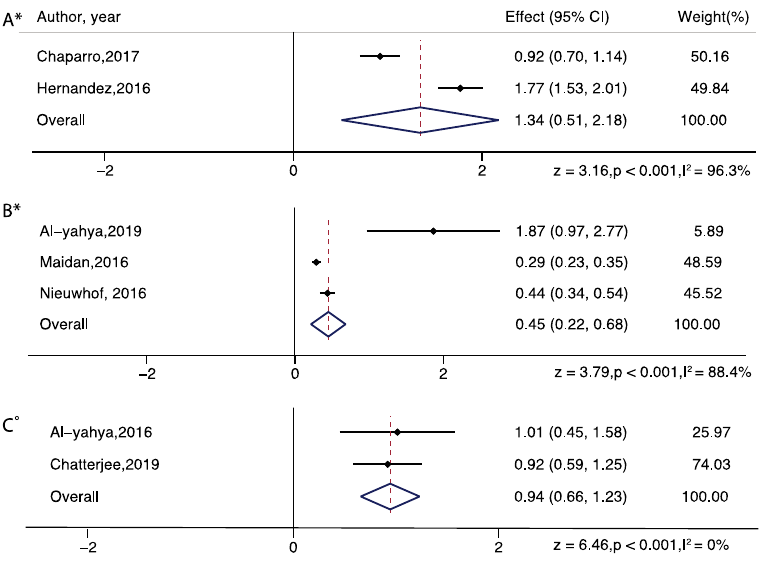
Figure 4. Brain activation differences while doing letter generation task ( A ) and serial subtraction task ( B , C ) in older adults with neurological diseases (multiple sclerosis-A, Parkinson’s disease-B, stroke-C). Note: ° represents Fixed plot meta-analysis, * represents Random plot meta-analysis.